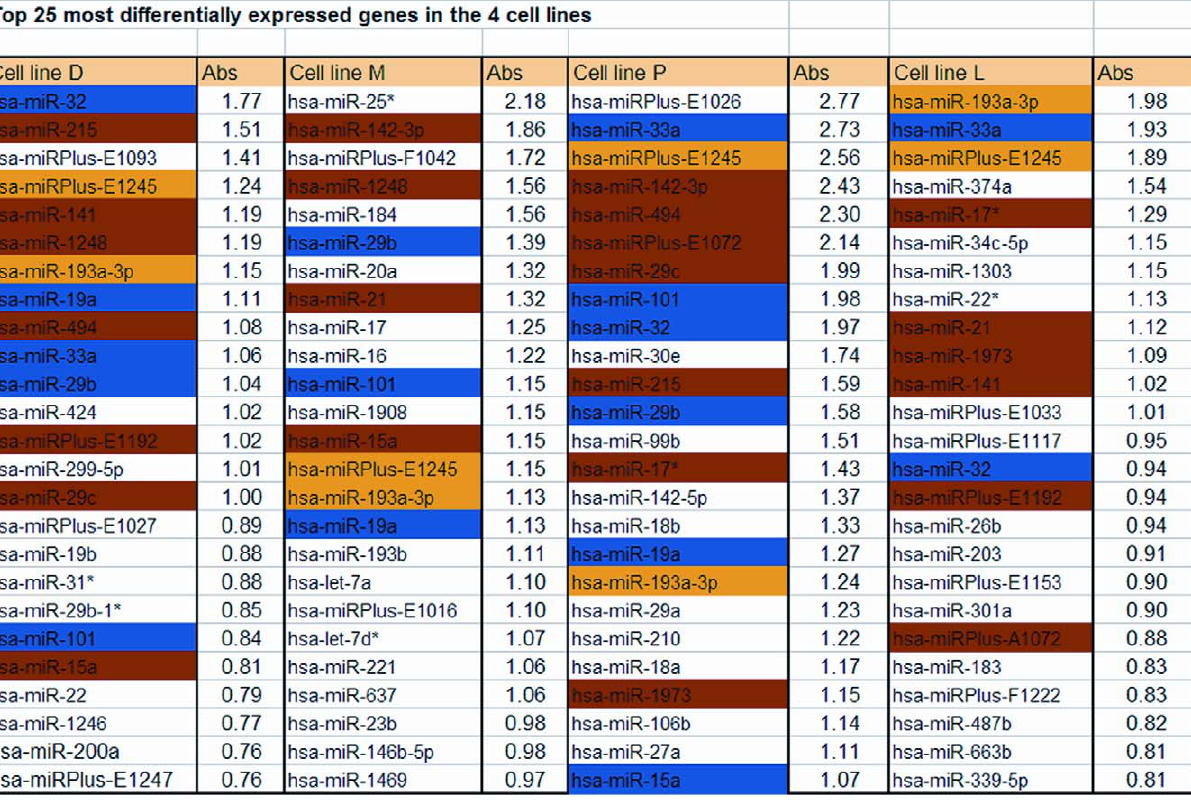
Figure 5. Tabular representation of top 25 most differentially expressed miRs in the 4 cell types ( D-DU145; L-LNCaP; P-PBL, and M- MDMs ). Yellow represents miRNAs present in all 4 lists (hsa-miR-193a-3p and hsa-miRPlus-E1245), blue represents miRNA present in 3 out of 4 lists and dark-red represents miRNAs present in 2 out of 4 lists.